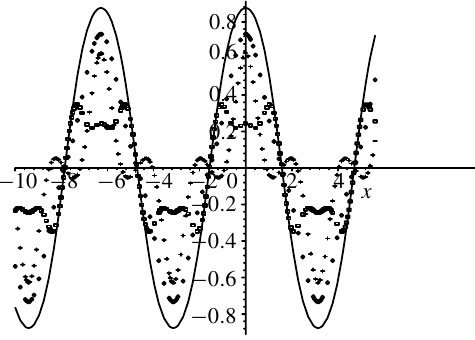
b Graph of second degree Maclaurin polynomials for the Sine-Gordon equa- tion using modified Picard iteration at t = h( · ) , 2 h( ◦ ) , 3 h( + ) , and 3 . 25 h( ✷ ) for h = 1 .